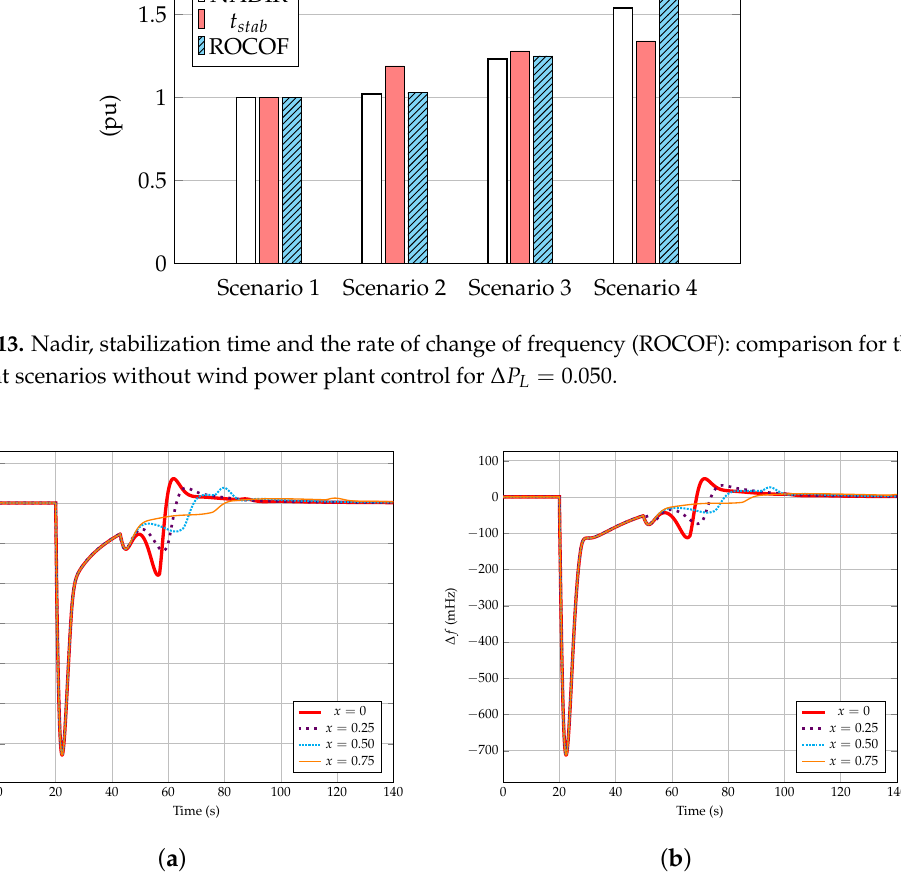
Figure 14. Frequency excursion for scenario 2. Comparison among values of x . ( a ) Considering ∆ P L = 0.050; ( b ) Considering ∆ P L =